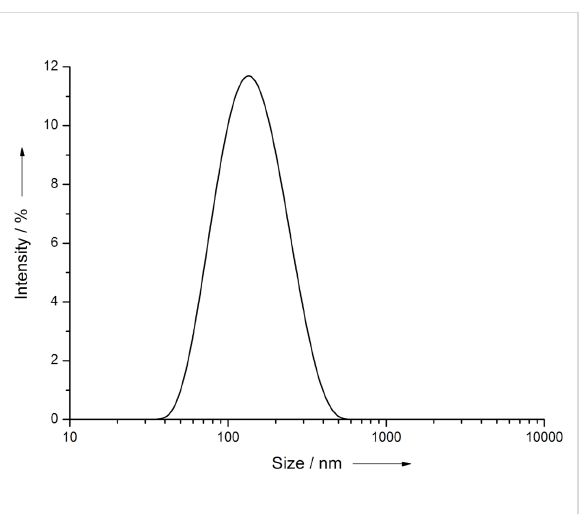
Figure 3: Particle intensity distribution of PVP-AgNP by dynamic light scattering (Nano Zetasizer ZS, Malvern, Herrenberg, Germany).